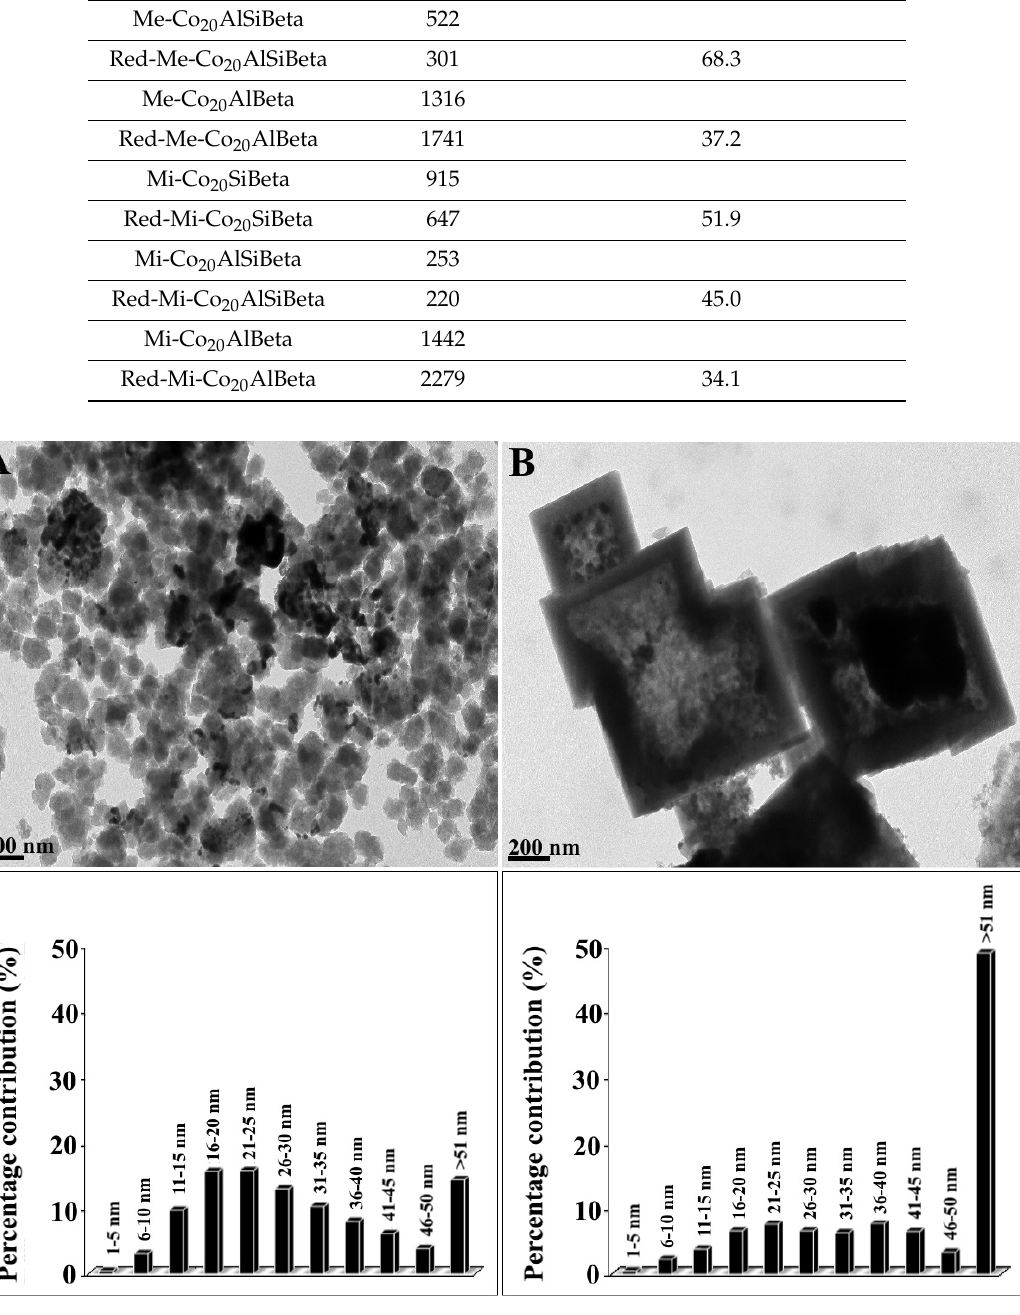
Figure 9. TEM images and metal nanoparticle size distribution on ( A ) Red-Mi-Co 20 AlSiBeta and ( B ) Red-Me-Co 20 AlSiBeta.